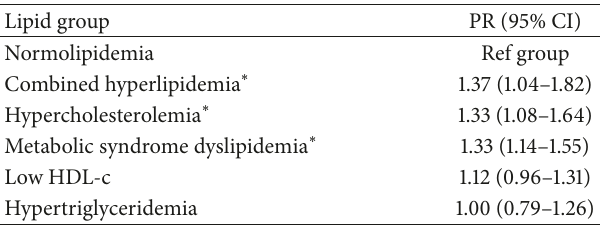
Figure1:Numberofcoronaryvesselswithcalcificationasafunction of lipid profiles. The between-group differences in the number of affected vessels with CAC, showing significant between-group dif- ferences (𝑝 < 0.001) . NL = normolipidemia, Combined = combined hyperlipidemia, HC = hypercholesterolemia, MetS = dyslipidemia compatible with metabolic syndrome, HTG = hypertriglyceridemia, and CAC = coronary artery calcification. Table 3: Unadjusted prevalence ratio of multivessel CAC as a func- tion of lipid